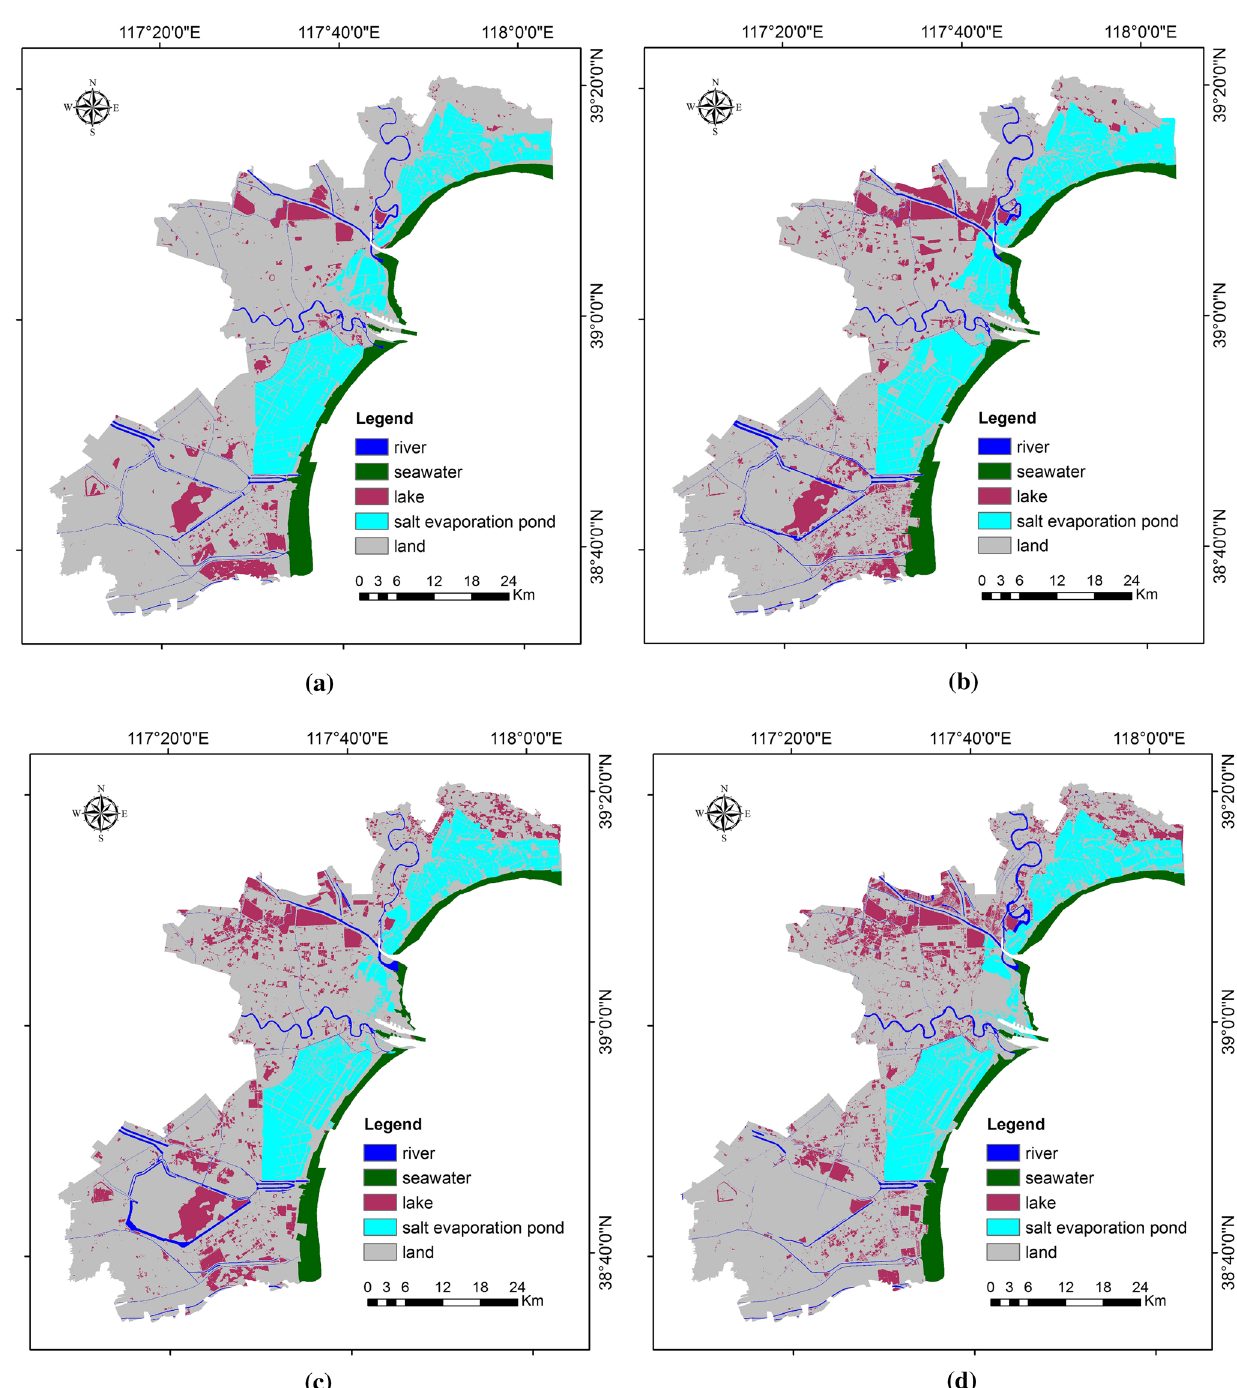
Fig. 4 Maps of surface water extraction using MNDWI-based adaptive dynamic threshold method: a 1985; b 1990; c 1995; d 2000; e 2005; f 2010; g 2014; h